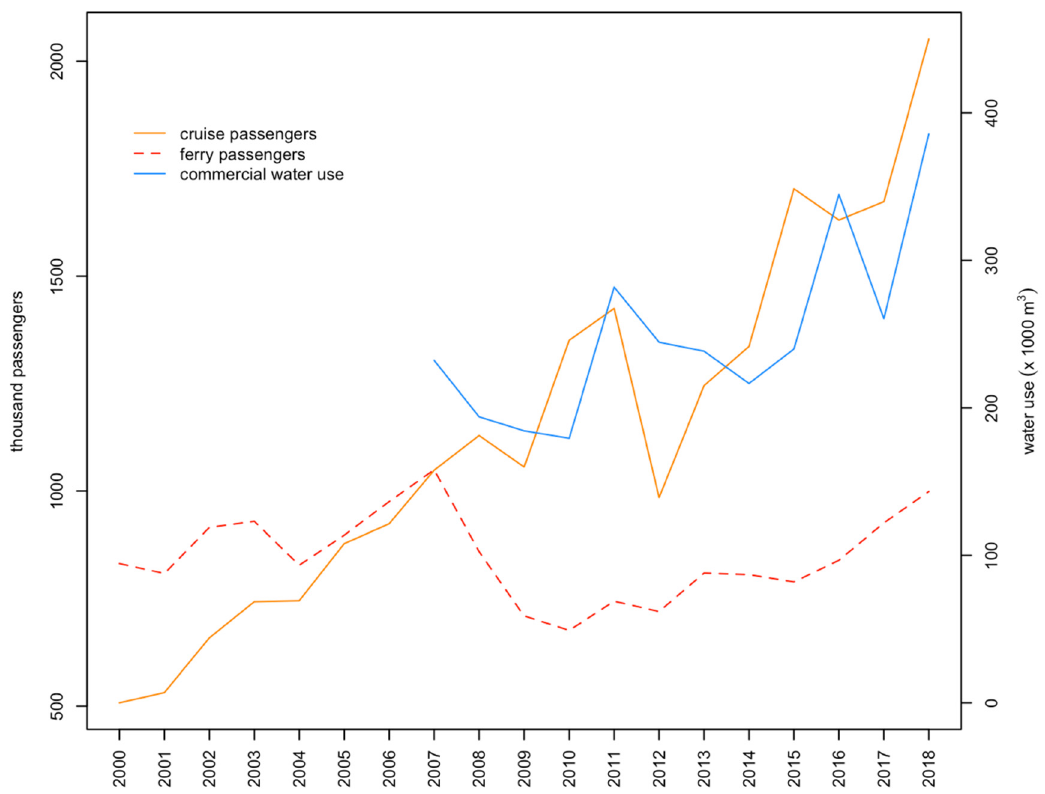
Figure 4. Historical series of dynamic of passengers and ships from cruisers and ferries, along with the water use in the port by the commercial sector.